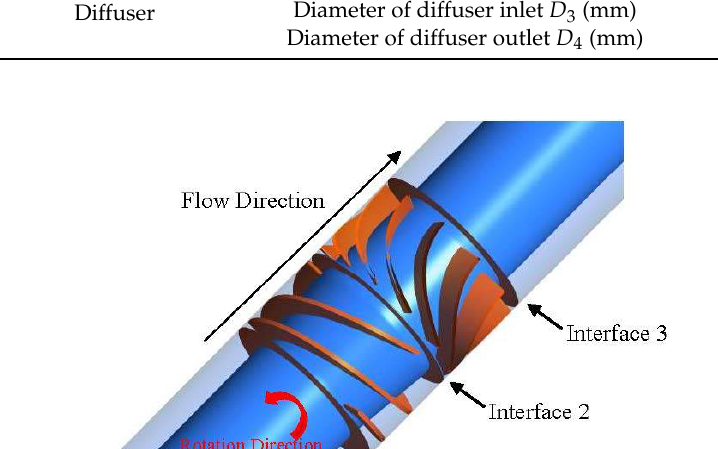
Table 1. Parameters of the model multiphase pump.